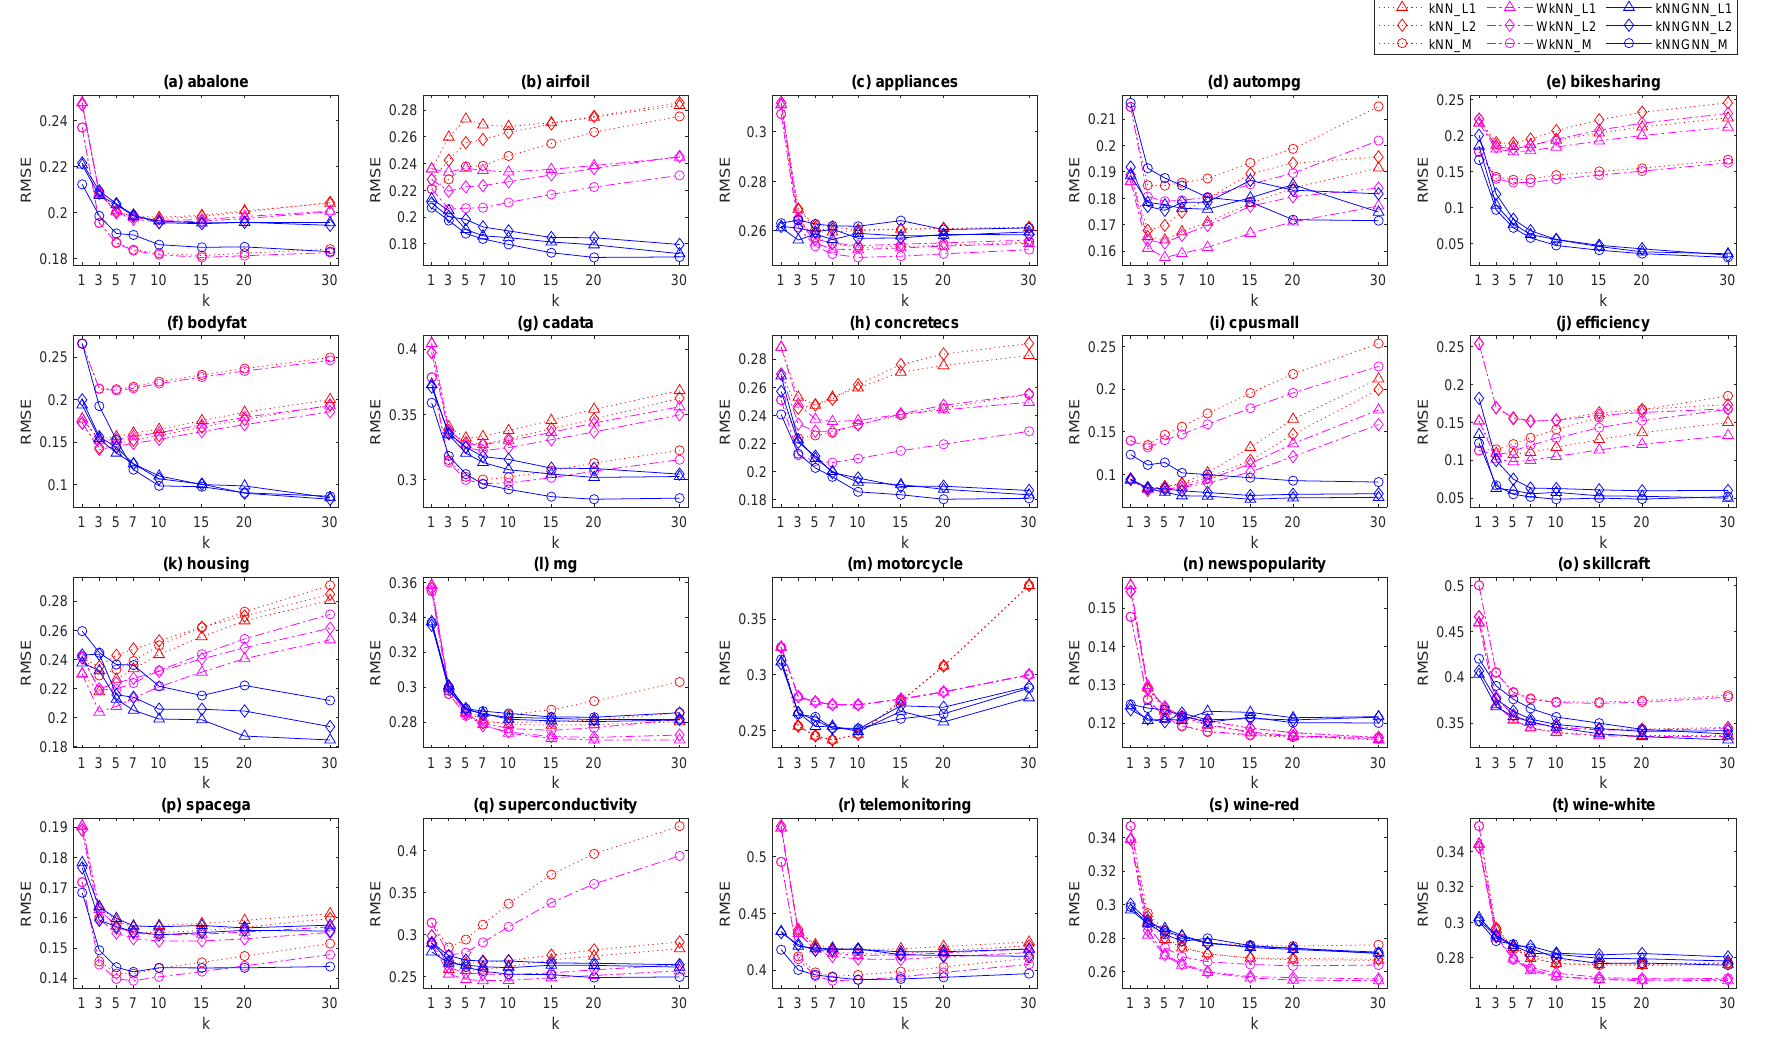
Figure 3. RMSE comparison with varying hyperparameters on regression